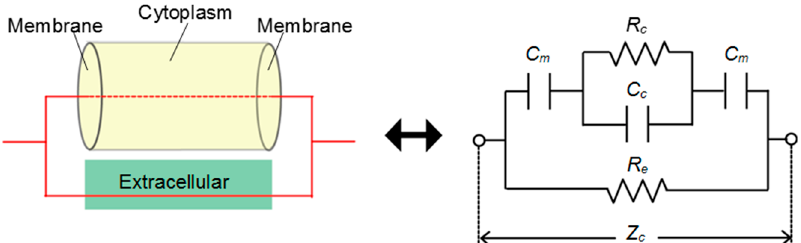
Figure 8. Equivalent circuit of a living cell. Cytoplasm was modeled as a parallel circuit of resistance R c and capacitance C c , cell membrane as capacitance C m , and extracellular medium as resistance R e .